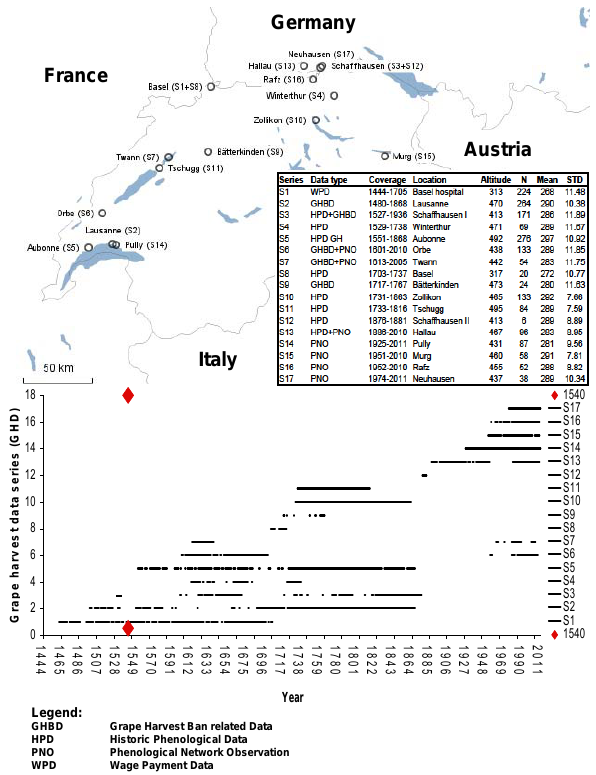
Fig. 2. Location-, metadata- and composition of 17 Swiss GHD series. Fig. 2. Location, metadata and composition of 17 Swiss GHD se- The new Swiss GHD series is composed from four different kinds of GHD, namely a) (institutional) Wage Payment Data (WPD) b) (Institutional) Grape Harvest Ban related Data- (GHBD), c) (individual) Historic Phenological Data- (HPD) d) (institutional) Phenological